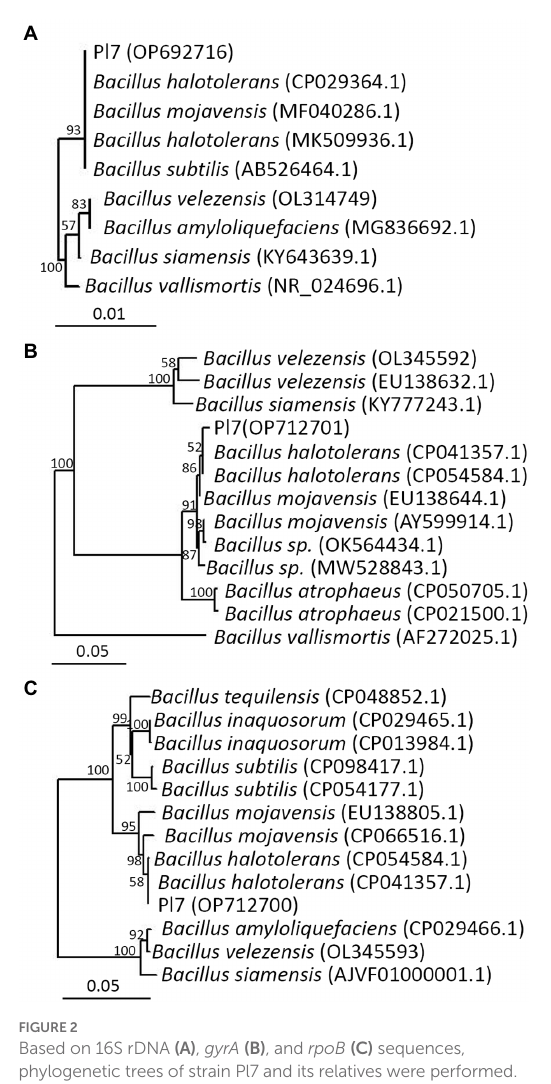
FIGURE 2 Based on 16S rDNA (A) , gyrA (B) , and rpoB (C) sequences, phylogenetic trees of strain Pl7 and its relatives were